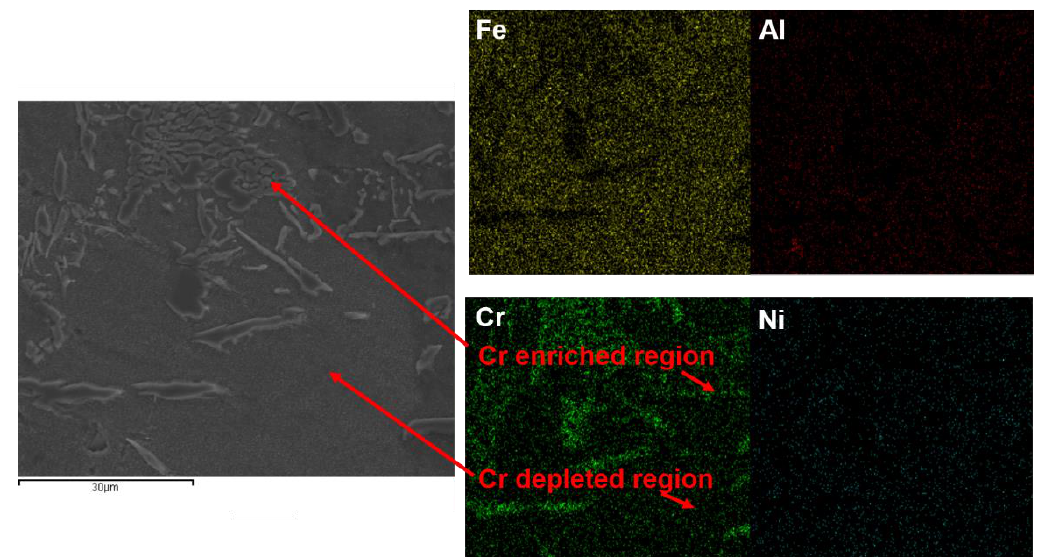
Figure 3. FESEM image of alloy #1, showing a sample grain and element distribution at a grain boundary. The distribution of elemental Cr is particularly important, as the distribution of elements coincides with that of phases.